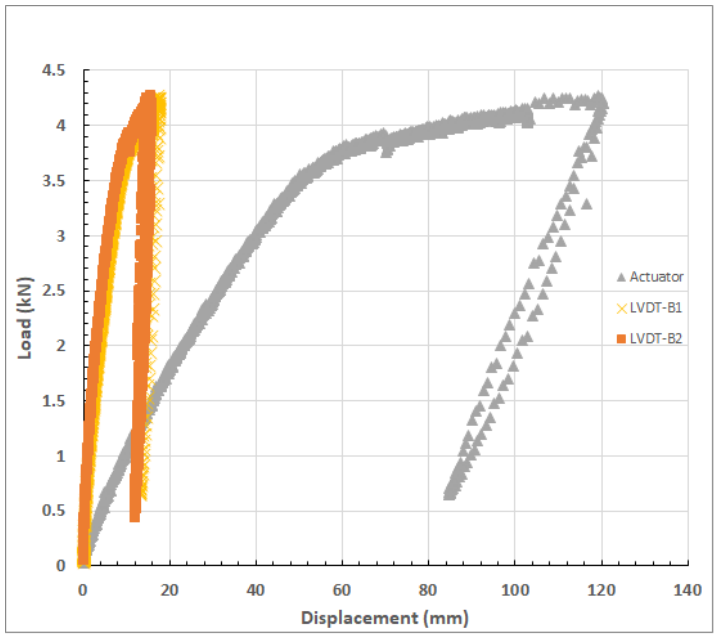
Figure 11. Load – displacement curve at initial cycles.